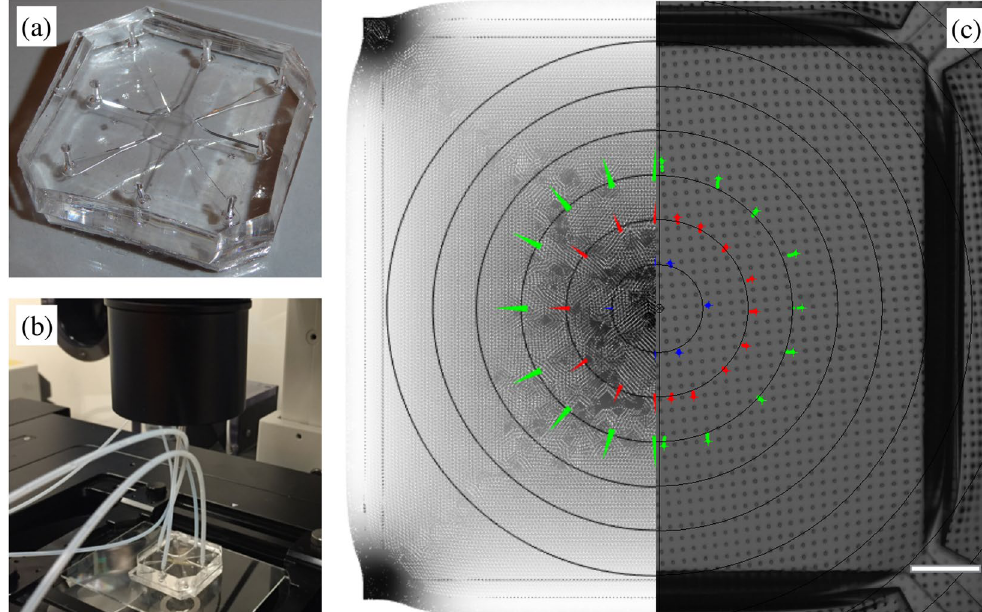
Figure 4. MCD actuation. ( a,b ) Optical macrographs of the MCD prototype ( a ) and of the actuation setup ( b ). ( c ) 1:1 comparison between simulated (left half) and experimental (right half) displacement fields for the porous membrane (PM) under actuation at a vacuum level of – 500 mbar (scale bar: 200 μ m ). Arrows in color highlight displacement vectors for a set of markers at different distances (250, 500, 750 μ m ) from the center of the